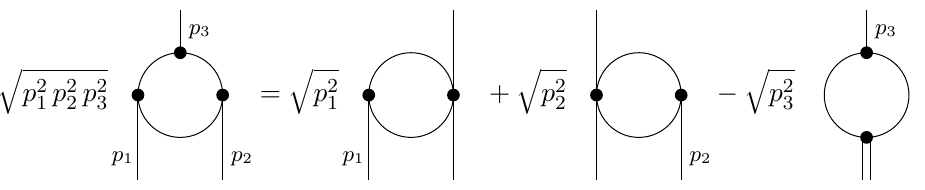
Figure 4 . Structure of the reduction of massless one-loop three-point functions with collinear momenta to one-loop two-point functions, such as for the specific example given in eq. (5.13). Here, all internal lines correspond to single-power massless progagators 1 / [ k 2 ] . We label the external momenta by p i , implying collinearity p 1 k p 2 , which we indicate by drawing the external lines